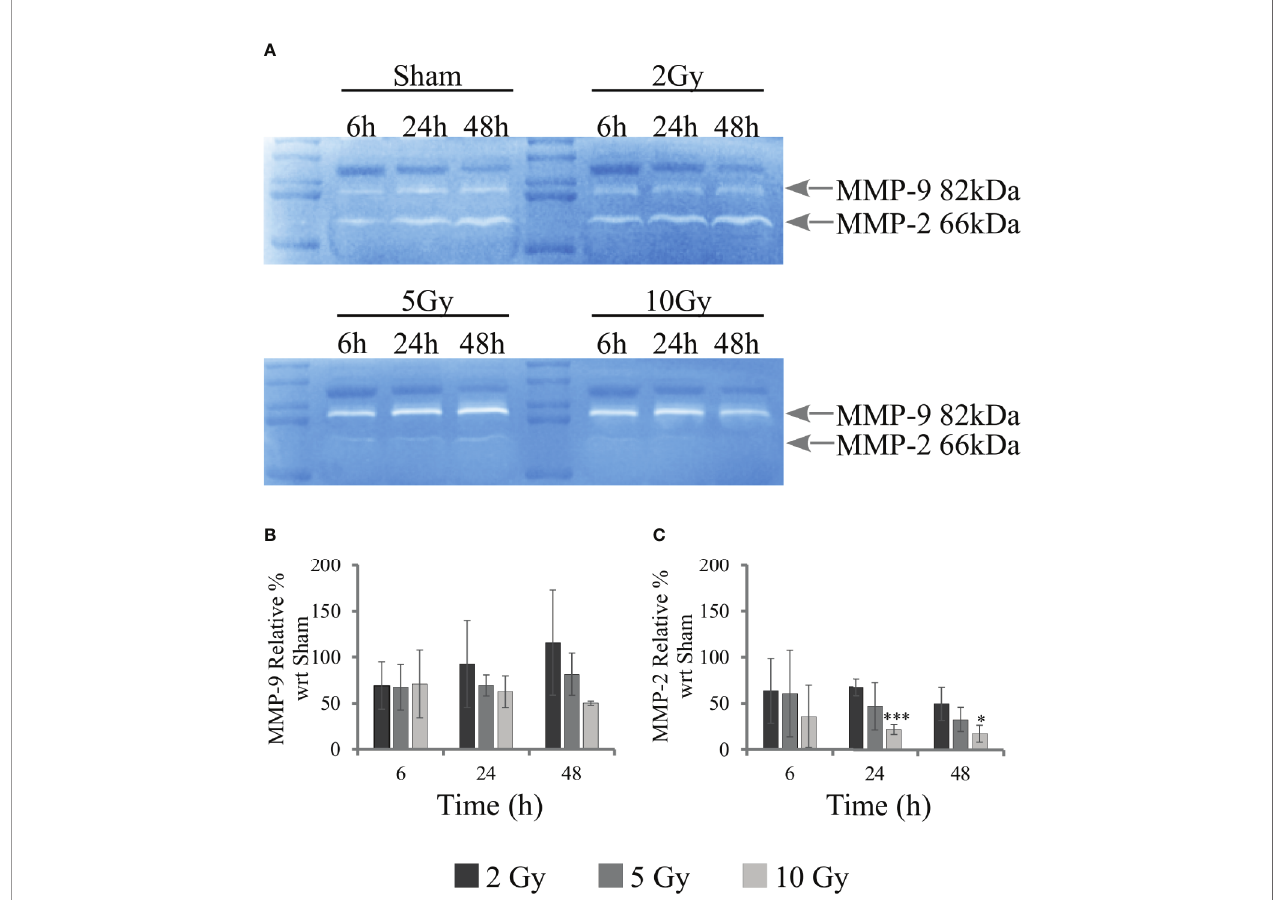
FIGURE 8 | Activity of MMPs with gelatin zymography analysis. For Caco-2 cells following the “ Seed + Treat ” protocol: (A) Representative images of gelatin zymography for the different irradiation conditions and time points, with identi fi cation of bands corresponding to MMP-9 and MMP-2; Quanti fi cation of MMP activity as a function of time for the different irradiation conditions (normalization is to the sham condition at the same time point) for: (B) MMP-9; (C) MMP-2. Data reported are mean ± SD, obtained from ≥ 3 independent experiments. Statistical signi fi cance (Student ’ s t-test) is as follows: *p < 0.05, **p < 0.01, ***p <